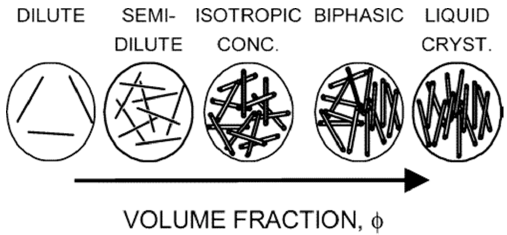
Figure 3. Phase behavior of dispersed rigid rods. Reprinted with permission from Davis, V.A.; Ericson,